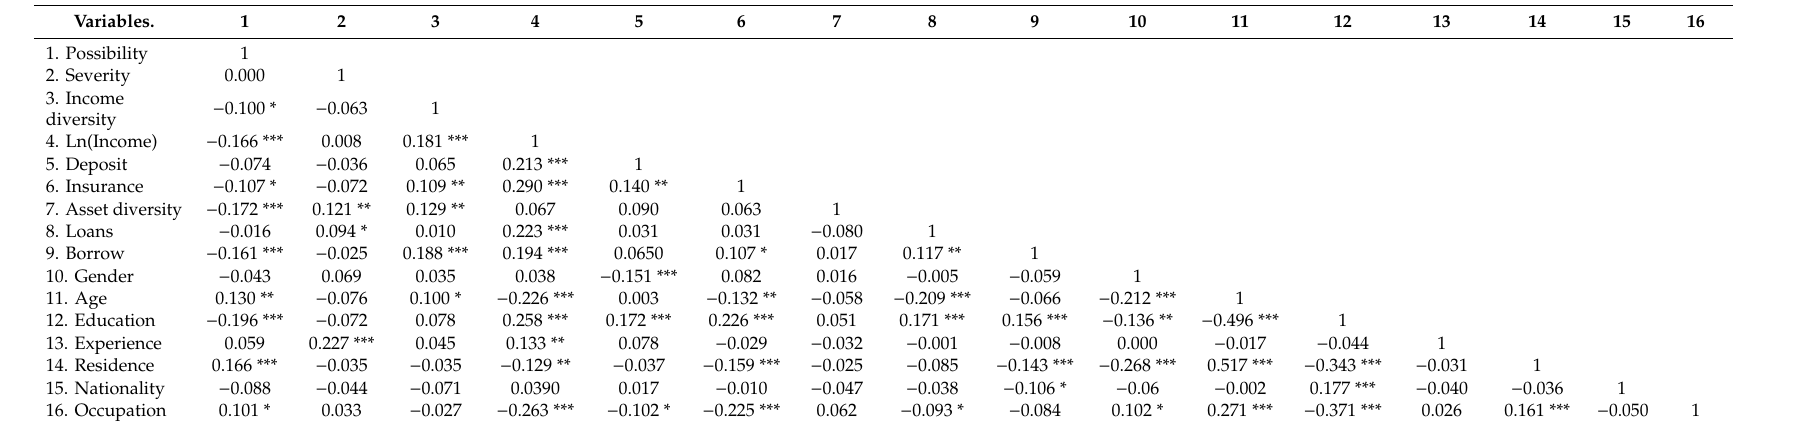
Table 4. The correlation coe ffi cient matrix of variables in the